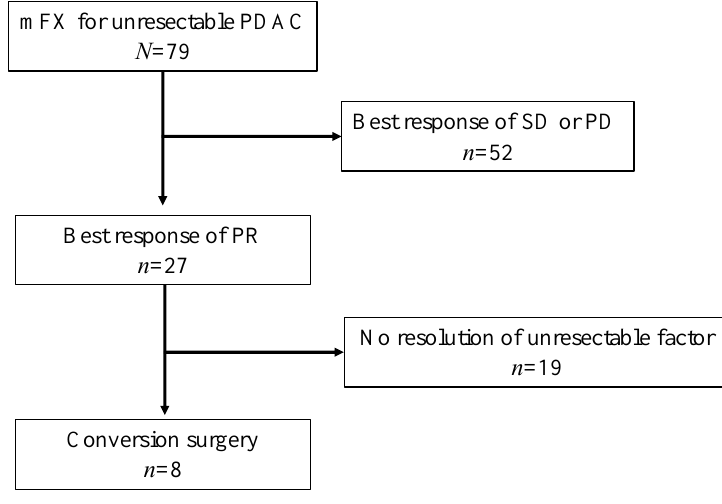
Figure 1. Patient flow.